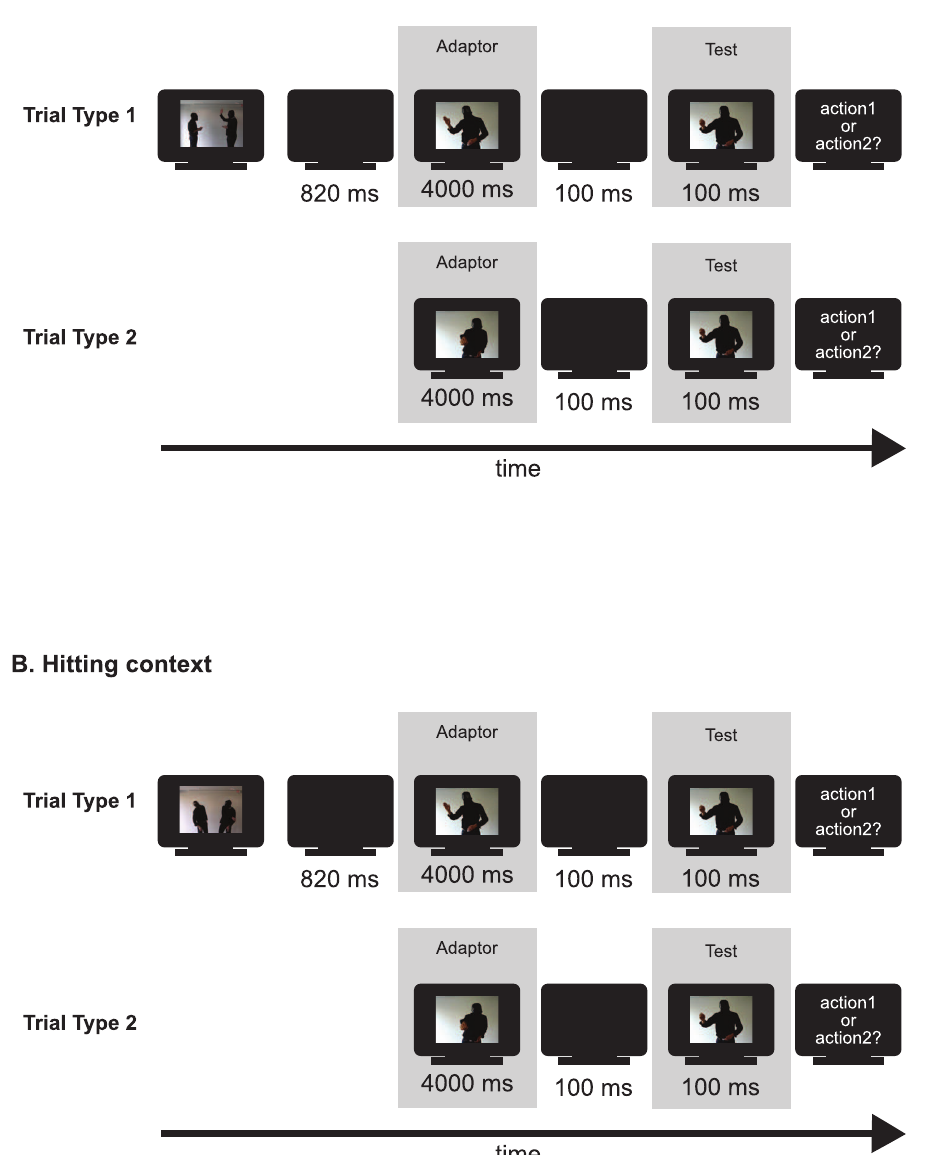
Figure 2. Experimental procedure . Schematic representation of the stimulus presentation procedure of the waving context condition ( A ) and the hitting context condition ( B ) of experiment 1. Each experimental conditions consists of two types of trials (shown at the top and bottom of each panel). The video displayed in Figure 1E was shown first in the first type of trial of the waving condition. The video displayed in Figure 1D was shown first in the first type of trial of the hitting condition. The presentation durations for each screen are given below each